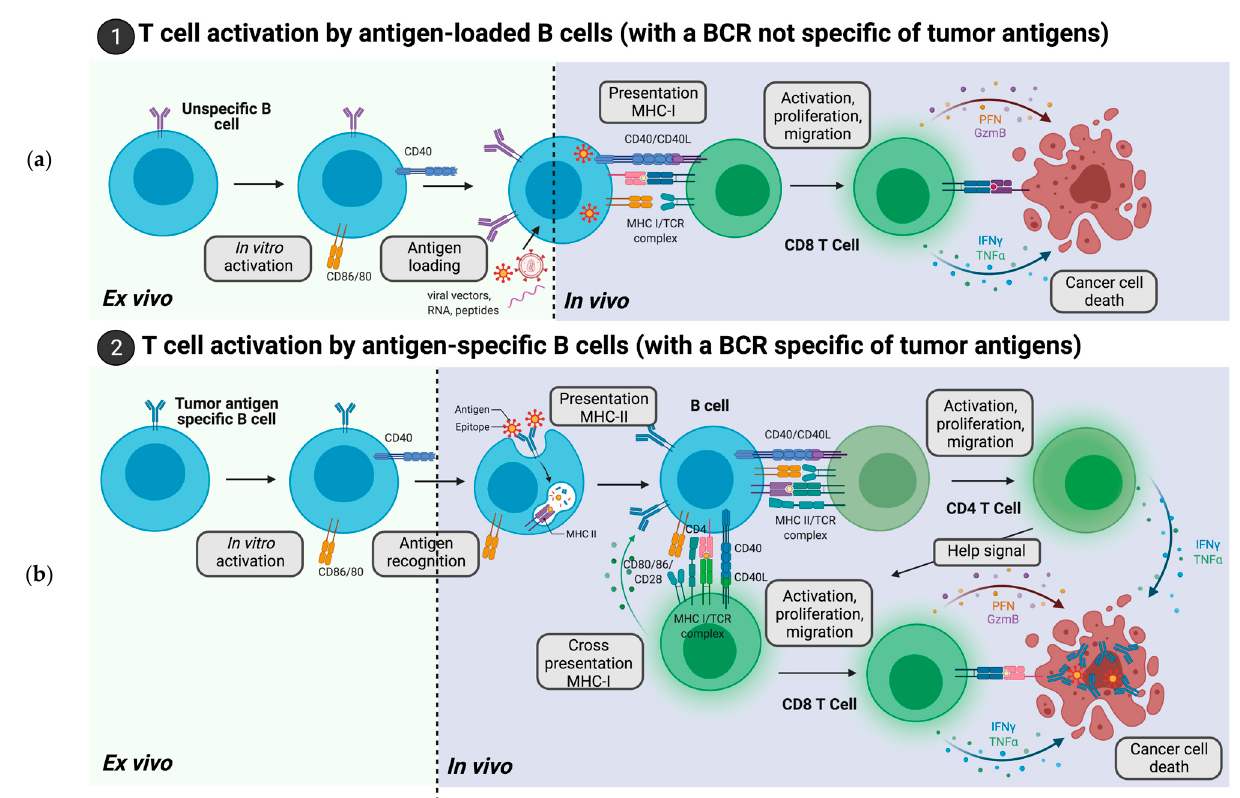
Figure 1. Tumor-specific T cell activation by B cells loaded with tumor antigens or with a BCR specific to tumor antigens. ( a ) B cells isolated from peripheral blood (human) or spleen (preclinical studies) are activated with a cytokine cocktail in vitro, which leads to the expression of costimulatory molecules such as CD40 and CD80/86, before being loaded ex vivo either directly with tumor peptides or with RNA or viruses encoding these peptides. This loading leads to the presentation of tumor antigens on MCH-I complexes, which interact with CD8+ T cells that are harboring a TCR specific of the presented antigen. This specific TCR/MCH-I antigen recognition combined with the CD40L/CD40 and CD28/CD80/86 interactions between, respectively, T and B cells leads to T cell activation. Once activated, the CD8+ T cells proliferate and migrate to tumor sites, where they secrete pro-inflammatory mediators (IFNg, TNFa), which boost the immune system locally, but also lysis molecules (perforin, granzyme) that directly destroy tumor cells. ( b ) Tumor-specific B cells isolated from a tumor-draining lymph node or generated by gene editing (see below) are expanded and activated in vitro (similarly to “a”) before infusion. When the tumor-specific B cells meet their target antigen in vivo, this leads to B cell activation, secretion of antibodies directed against this tumor antigen and presentation of the tumor antigen on MHC-II complexes. The presentation of tumor antigens on MCH-II leads to the activation of antigen-specific CD4+ T cells, which proliferate and provide the ‘help’ signal required for the activation of several T cell subtypes. Of note, antigen-specific CD8+ T cells can also be activated by B cells after cross presentation of tumor antigens on MCH-I complexes. In addition to the effects of activated T cells on tumor survival, the antibodies directed against tumor epitopes, secreted by B cells, are also involved in tumor clearance by triggering the activation of the complement system (CDC), the phagocytosis of tumor cells (ADCP) and the lysis of tumor cells (ADCC).